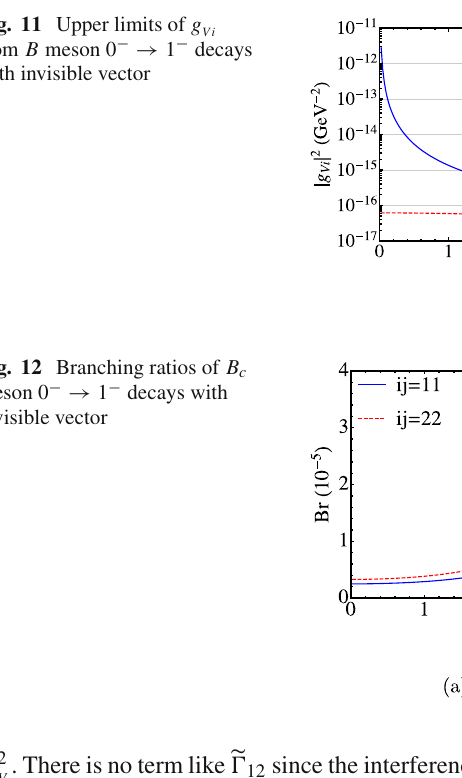
Fig. 11 Upper limits of g from B meson 0 − → 1 − decays with invisible vector